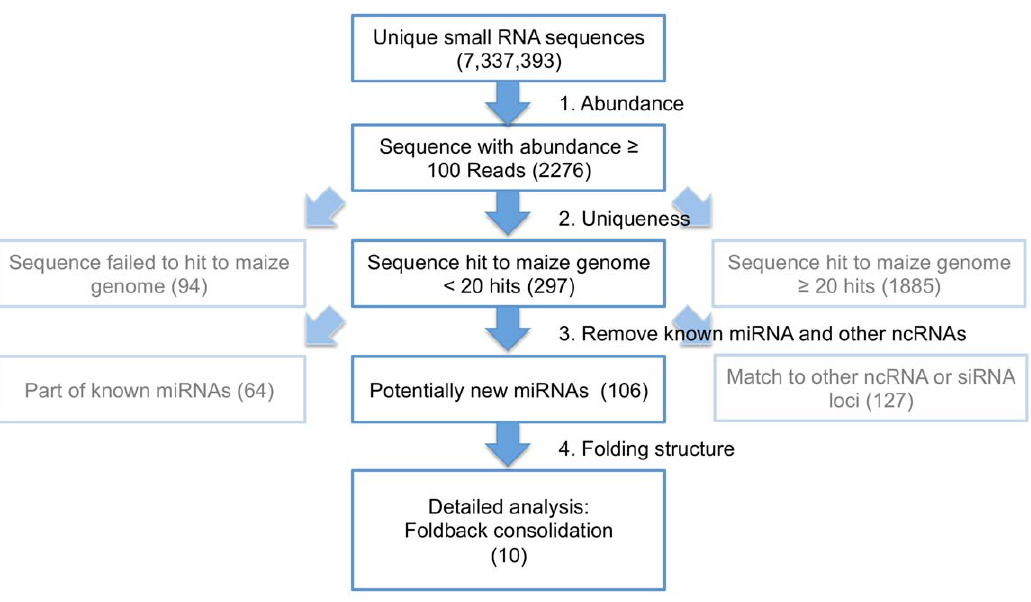
Figure 3. Flowchart of the novel miRNA prediction pipeline. The flowchart shows the filtering criteria to reduce and refine the numbers of small RNAs to the most interesting subset based on the abundance, removal of repeats (uniqueness), removal of known miRNAs, other ncRNAs, and folding structure. 10 unique sequences were identified as potentially novel miRNA candidates. Light blue squares show the filtered out sequences. Blue squares show the sequences that passed the filter.